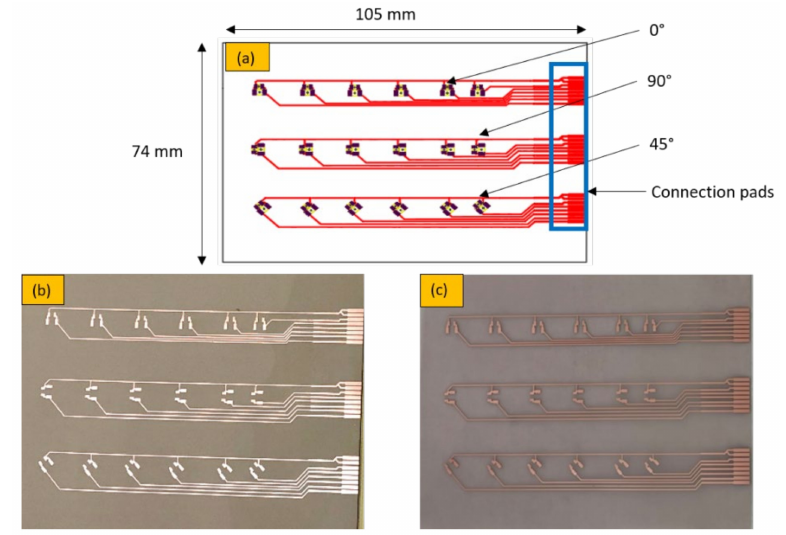
Figure 2. ( a ) Schematic foil design, ( b ) PI-Cu foil, and ( c ) PET-Cu